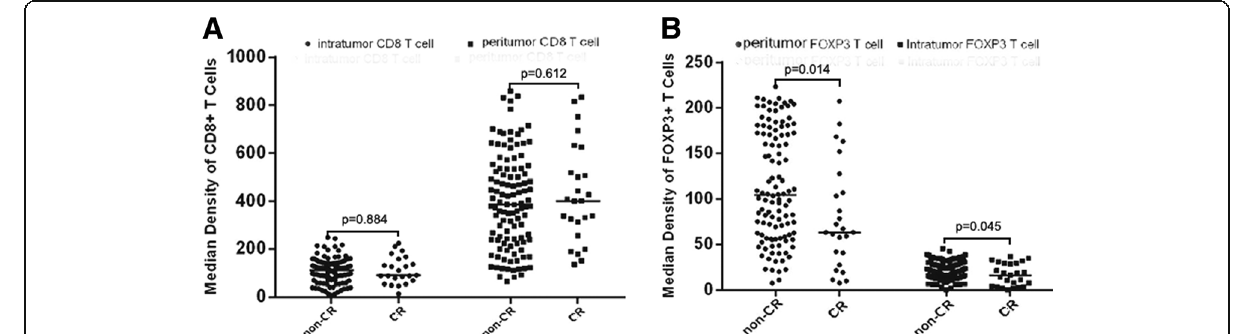
Fig. 3 The comparison of CD8+ and Foxp3+ T cells in residual tumors between pCR and non-pCR patients. There were no significant differences of intratumoral and peritumoral CD8+ cells between pCR and non-pCR cases ( a ). However, the Foxp3+ T cells, in both intratumoral and peritumoral areas, were significantly lower in pCR patients than in non-pCR ( b )